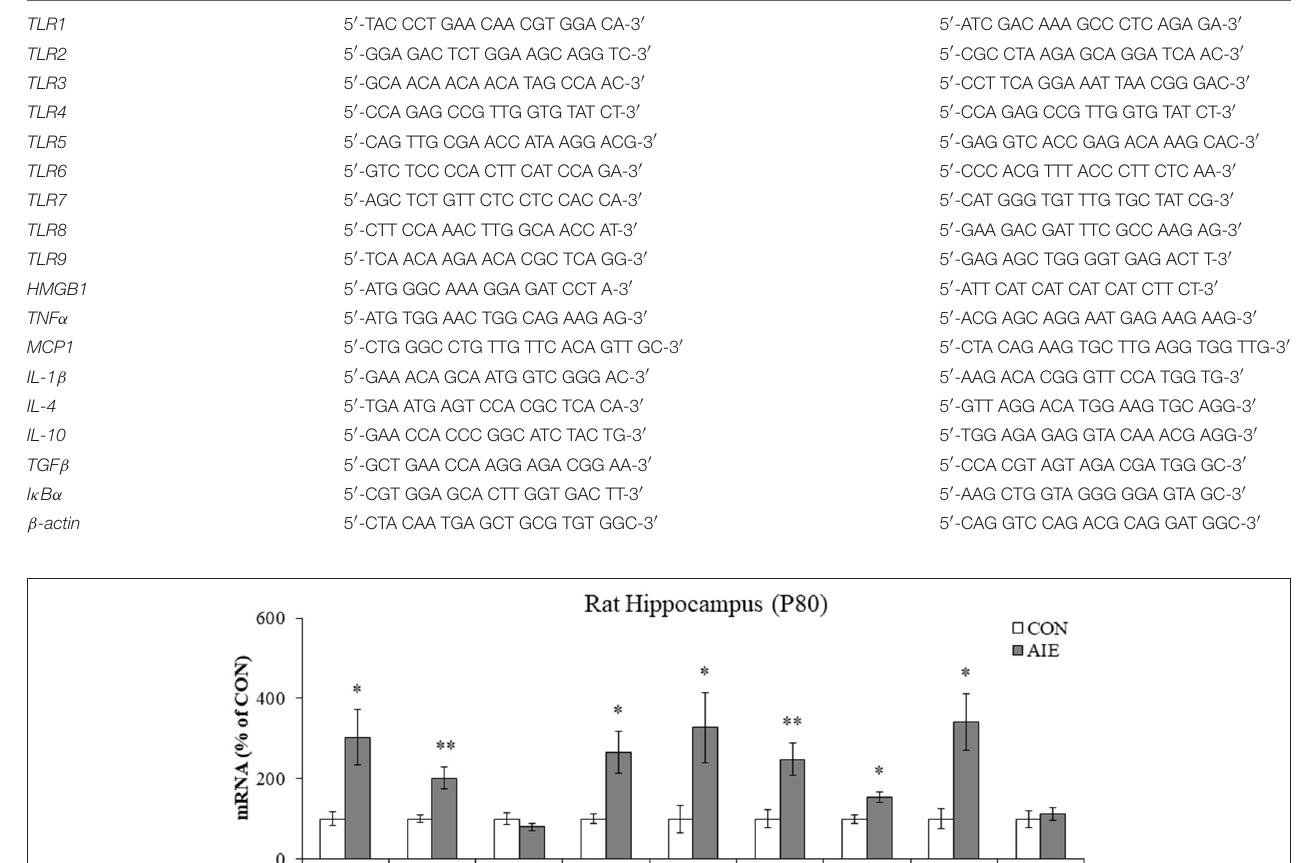
Frontiers in Neuroscience |